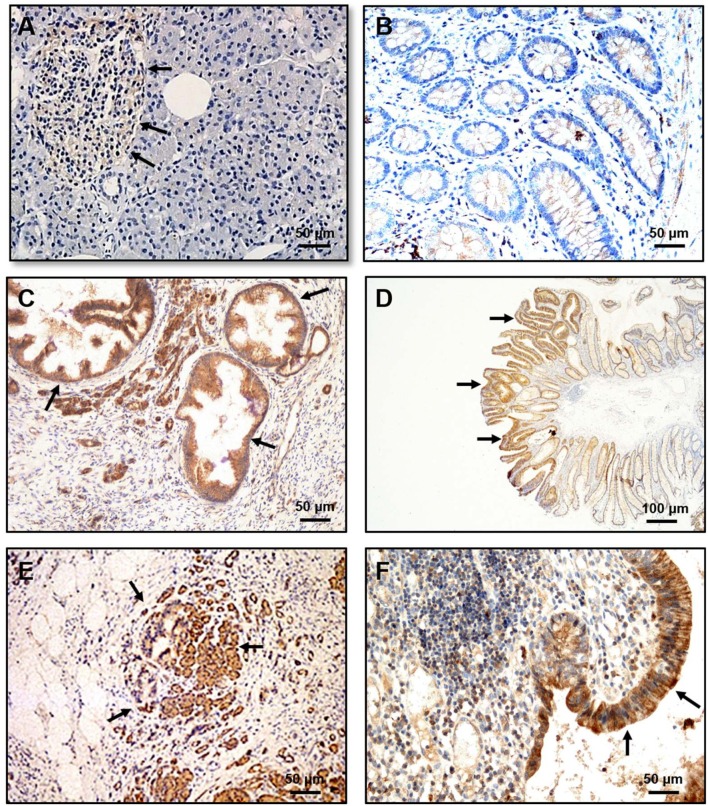
Immunohistochemical expression of OX1R in PanIN, dysplastic colonic polyp, pancreatitis and ulcerative colitis (UC). (A) OX1R was not detected in the normal pancreas either in normal duct and acinar cells. (B) OX1R was not detected in colonic mucosa. (C) OX1R was expressed in PanIN lesions. (D) OX1R was expressed in dysplastic cells present in colonic polyps. (E) OX1R immunostaining of colonic mucosa from patients with pancreatitis. (F) OX1R immunostaining of colonic mucosa from patients with UC. Arrows indicated the OX1R expression. Bar = 50 μm for (A, B C, E, F); Bar = 100 μm for (D). The sources of graphs were based on Voisin et al. (44), Dayot et al. (46), and Messal et al. (56).